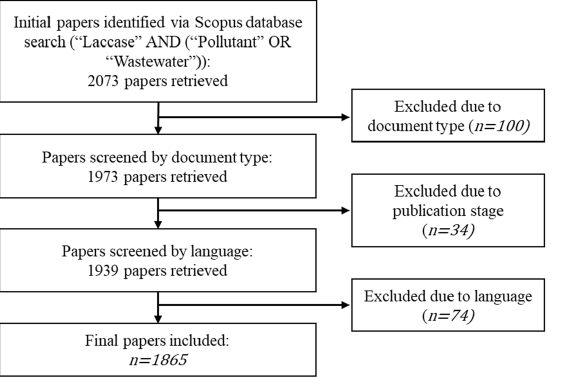
Figure 1. Flowchart of included studies on laccase utilization in wastewater treatment.